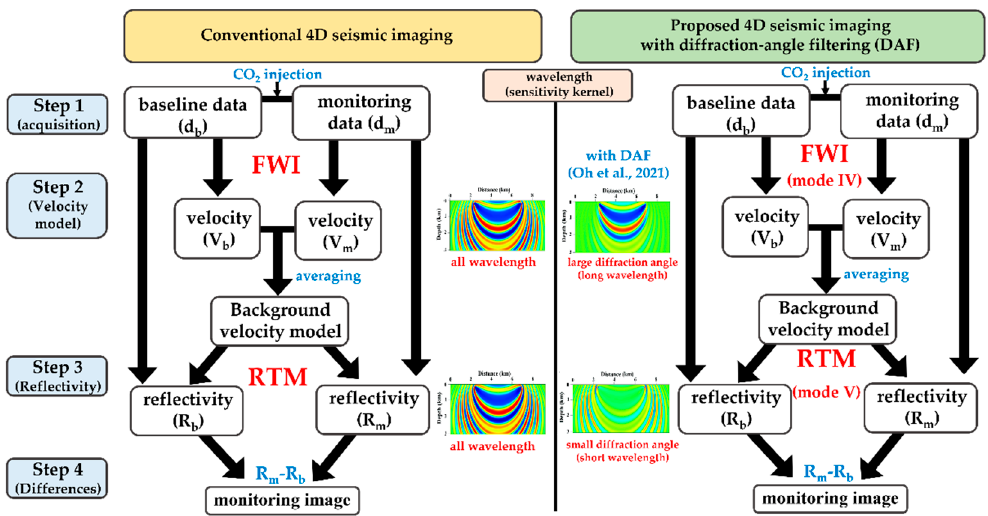
Figure 3. Workflow diagram of 4D seismic imaging with DAF [19] compared to conventional 4D seismic imaging.